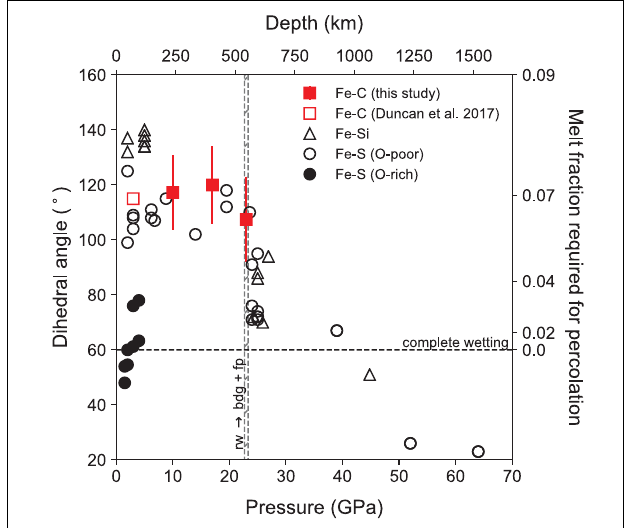
FIGURE 7 | Dihedral angle of Fe-rich melt in silicate or silicate plus oxide matrix as a function of pressure. The dihedral angles of Fe–C melt from this study (solid squares with error bar) and that of between an Fe–C melt containing 4.3 wt% carbon in olivine (open square, Duncan and Fei, 2017) are above 100 ◦ . Plotted for comparison are data on oxygen-poor Fe–S melt (open circles, Terasaki et al., 2008), oxygen-rich Fe–S melt (closed circle, Shannon and Agee, 1996, 1998; Shi et al., 2013), and Fe–Si melt (Open triangles, Takafuji et al., 2004; Mann et al., 2008). Dashed horizontal line marks the critical angle of 60 ◦ for complete wetting. The vertical bar marks the boundary where ringwoodite (Rw) breaks down to form bridgmanite (Bdg) and ferropericlase (Fp). The melt fraction required for percolation at a given dihedral angle, known as the percolation threshold, is marked on the right Y -axis.